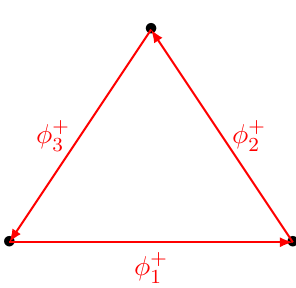
Figure 2. C [ (cid:22) ] for (cid:22) = ( N; 0) with maximal Higgs (cid:30) + weights of ( N; 0), which are connected by the maximal Higgs 2 End( H (cid:22)